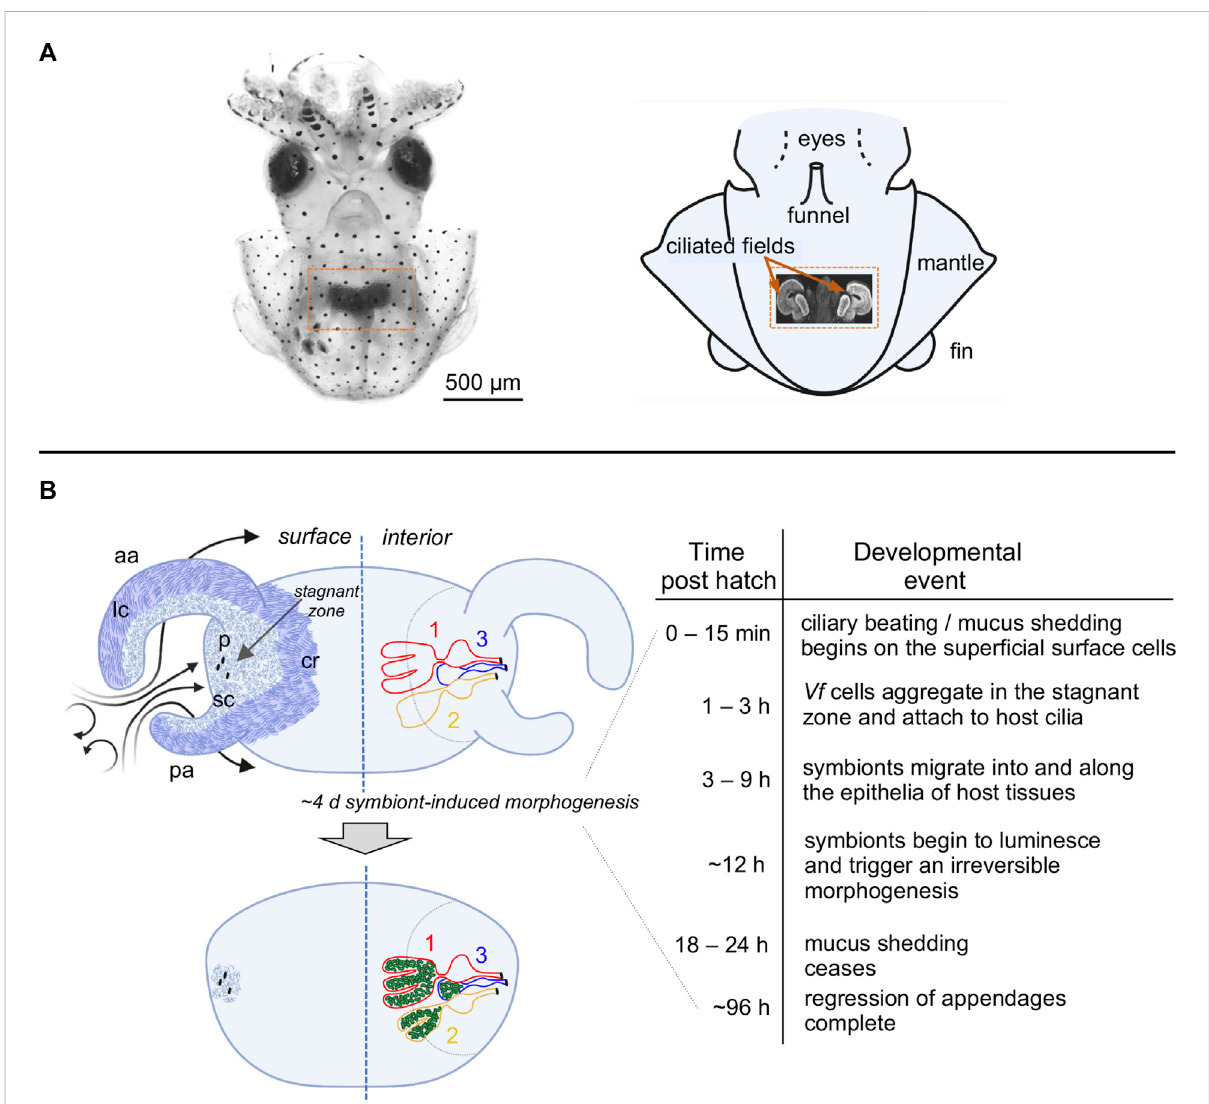
FIGURE 1 The light organ of Euprymna scolopes , and relevant early post-hatch events in the establishment of symbiosis. (A) The position of the organ in the body cavity. Left, a light micrograph of a juvenile E. scolopes , showing the location of ink-sac-associated light organ within the body cavity (orange box). Right, a diagram of a hatchling squid with a portion of the mantle removed to reveal a confocal micrograph (inset) of the internal light organwithitslateralciliated fi elds(orangearrows). (B) Earlydevelopmentofthelightorganundernaturalconditionspostsymbiontcolonization (left)andthetimelineoftheassociatedevents(right). Upperleft — athatching,eachexteriorlateralsurfaceiscoveredwithtwodistinctpopulationsof cilia:(i)longermetachronally-beatingcilia(lc;darkerblueareas)alongtheouterregionsoftheanterior(ap)andposterior(pa)appendages,andalong the medial ciliated ridge (cr); and, (ii) shorter randomly beating cilia (sc) (lighter blue areas), which cover the inner surfaces of the appendages, and surround the pores (p) into which the symbionts migrate. Following recruitment to a stagnation zone above the pores, V. fi scheri cells will migrate into the pores and down a migration path into three blind-ended crypts (1, 2, 3) on each side of the organ, where they will proliferate and populate these spaces. Lower left — by ~4d, colonizing symbionts (green) induce a developmental program that results in a gradual loss of the super fi cial ciliated fi